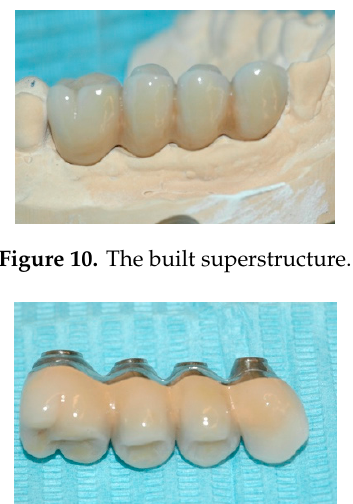
Figure 11. The built superstructure.